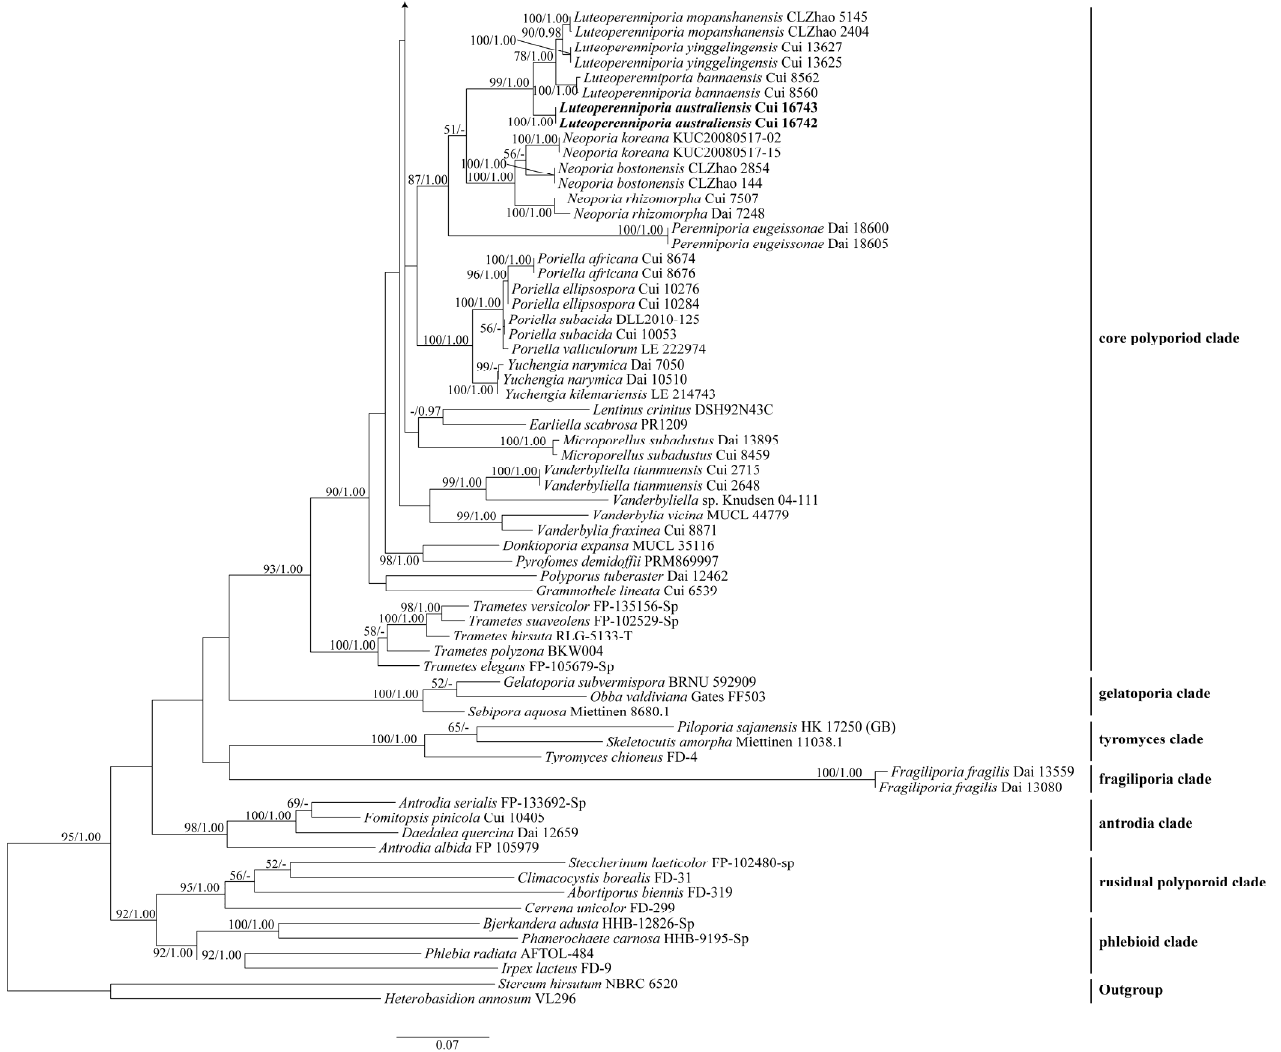
Figure 1. Maximum likelihood tree illustrating the phylogeny of Perenniporia and related species in Polyporales based on the ITS + nLSU dataset. Branches are labeled with maximum likelihood bootstrap support values ( ≥ 50%) and Bayesian posterior probabilities ( ≥ 0.90). The combined five-gene (ITS, nLSU, mtSSU, TEF1, TBB1) sequence dataset included sequences from 119 fungal samples representing 70 taxa. The dataset had an aligned length of 3498 characters, of which 2285 characters were constant, 226 were variable and parsimony-uninformative, and 987 were parsimony-informative. BI analysis generated topologies similar to those of ML analysis, with an average standard deviation of split frequencies = 0.007253 (BI). The topology from the ML analysis with a maximum likelihood bootstrap (BS) ≥ 50% and Bayesian posterior probabilities (BPP) ≥ 0.90 labeled on branches is shown (Figure